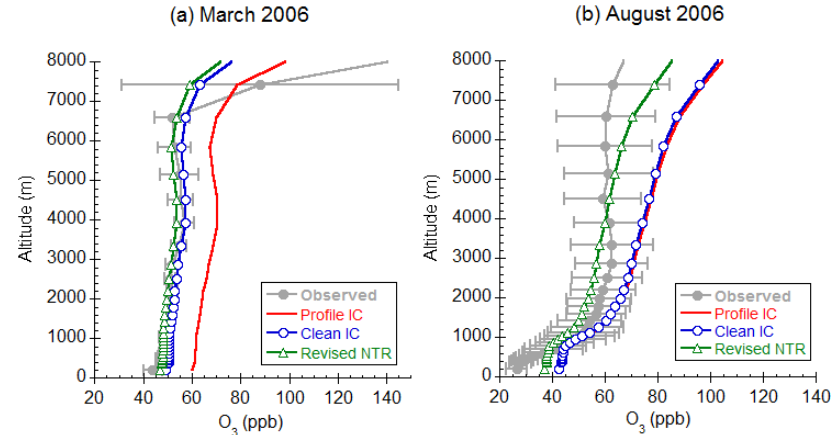
Figure 4. Comparisons of simulated average vertical profiles of O 3 with ozonesonde measurements at Trinidad Head, California, USA: (a) March 2006 (4 months after start of simulation) and (b) August 2006 (9 months after start of simulation). Also shown is ± 1SD of the observed mixing ratios. “Profile IC” uses the default profile for initialization as in regional CMAQ applications, “Clean IC” is the case in which the model is spun up from clean conditions, and “Revised NTR” is the simulation with “Clean IC” with updates to the physical and chemical sinks for the species NTR representing organic